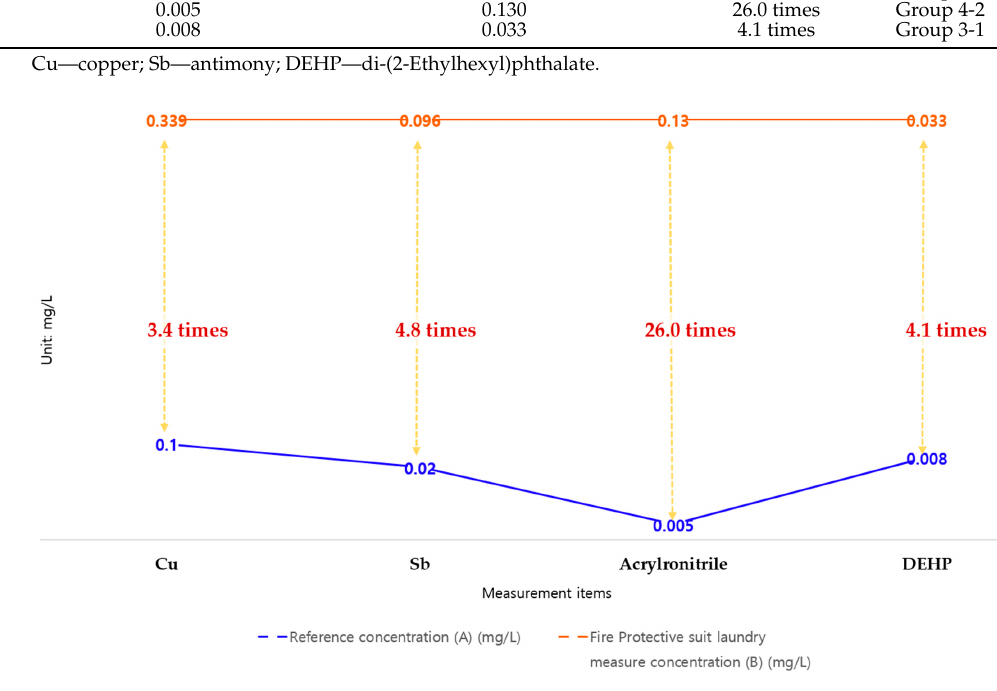
Figure 2. Comparison of measurement result and act standard. Cu—copper; Sb—antimony; DEHP—di-(2-Ethylhexyl)phthalate.